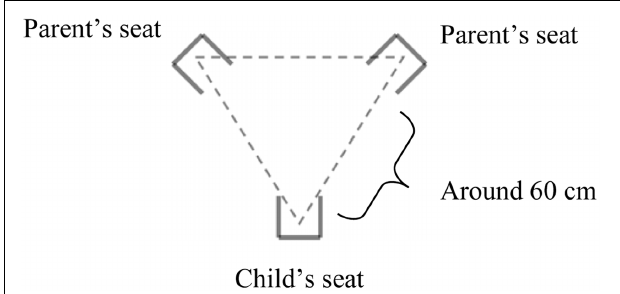
FIGURE 1 | Triangular arrangement of partners in the Lausanne Trilogue